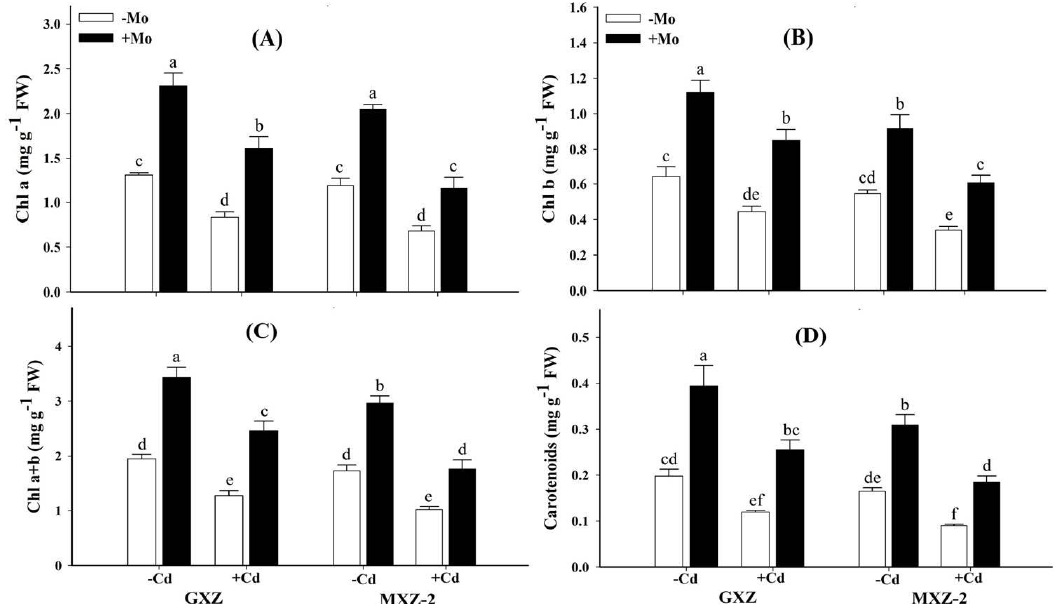
Figure 1. Influence of molybdenum (Mo) and cadmium (Cd) on; ( A ) chlorophyll a (Chl a); ( B ) chlorophyll b (Chl b); ( C ) total chlorophyll (Chl a+b) and ( D ) carotenoids contents in leaves of two fragrant rice Guixiangzhan (GXZ) and Meixiangzhan-2 (MXZ-2) cultivars. Both fragrant rice cultivars were treated with two molybdenum levels: 0 µM (–Mo) and 1 µM (+Mo), against two cadmium levels: 0 µM (-Cd) and 100 µM (+Cd) in modified Hoagland solution. Vertical bar above indicates standard error of four replicates. Different lowercase letters (a, b, c, etc.) represent significant differences according to the LSD-test ( p < 0.05, n = 4).